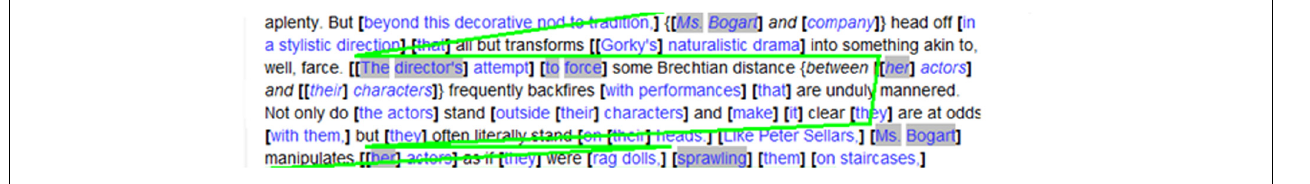
FIGURE 3 | A sample of text annotation in MMAX2.